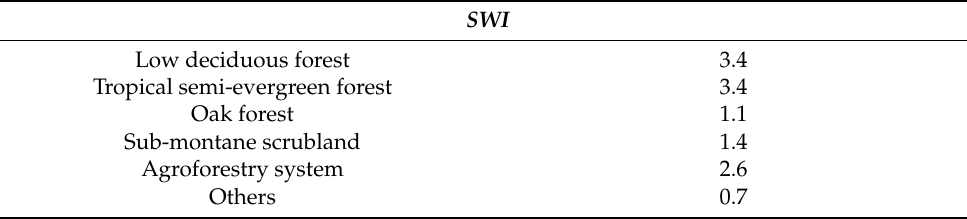
Table 5. Shannon–Wiener Biodiversity Index ( SWI ) results.